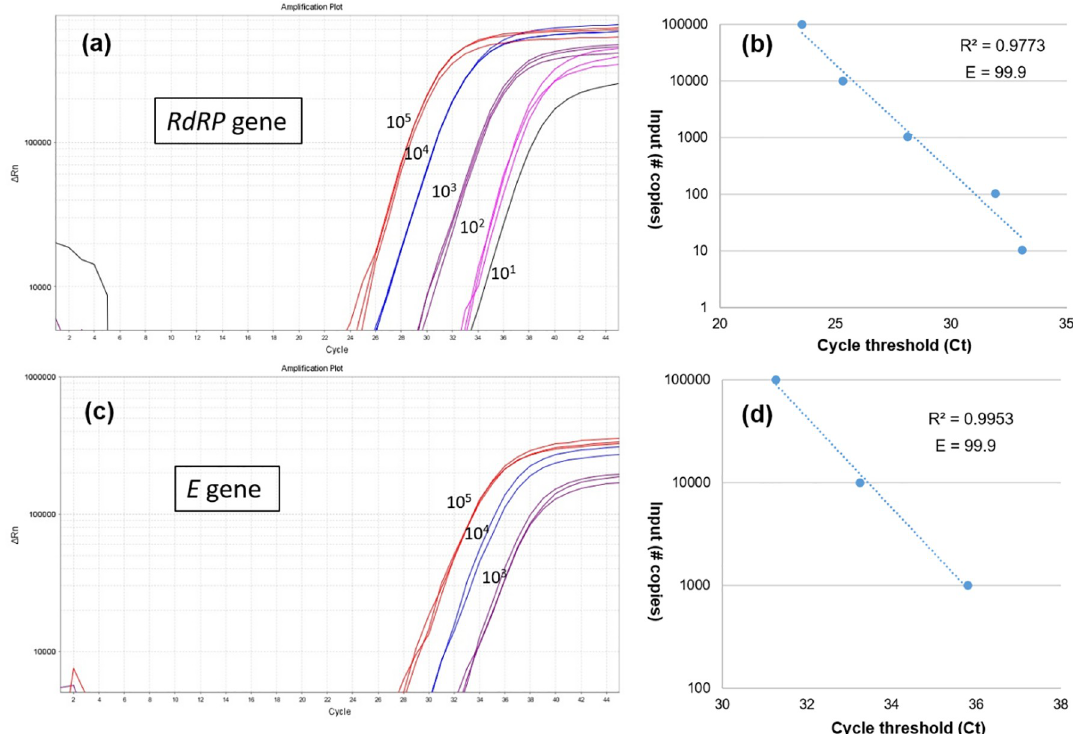
Fig 2. The limit-of-detection (LOD) of RdRP and E genes. A serial dilution of synthetic RNA (10 5 , 10 4 , 10 3 , 10 2 and 10 1 copies/ μ L) was prepared. The amplification plots ( a, c ) and the amplification efficiencies (E) (b, d) were represented.